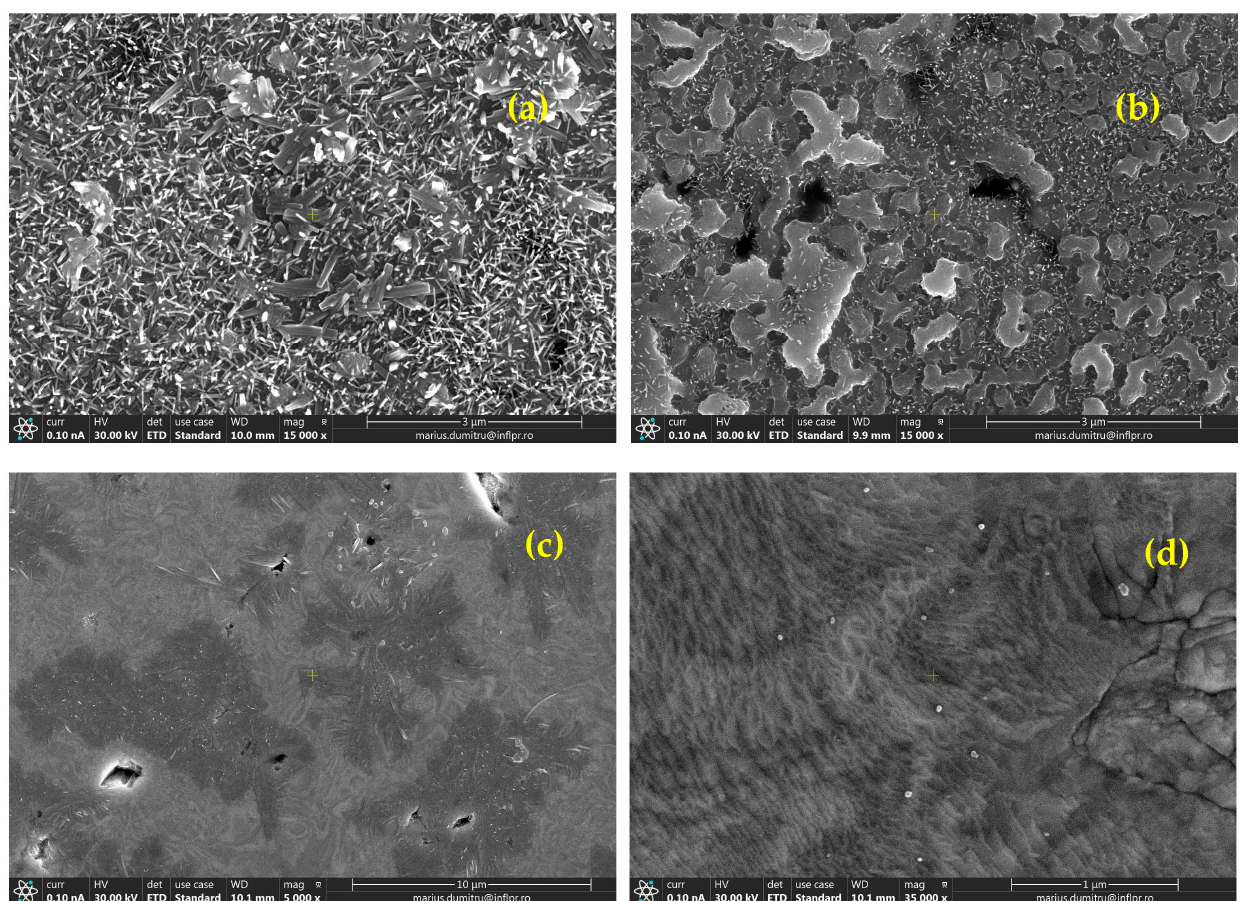
Figure 12. SEM images, obtained using a secondary electron detector, of the exposed surfaces of different W-metallic materials after 6 MeV electron irradiation: ( a ) W-Cr 0.6%, ( b ) W-Cr 1.0%, ( c ) W-Fe 0.5% and ( d ) W-Fe 1.0%.